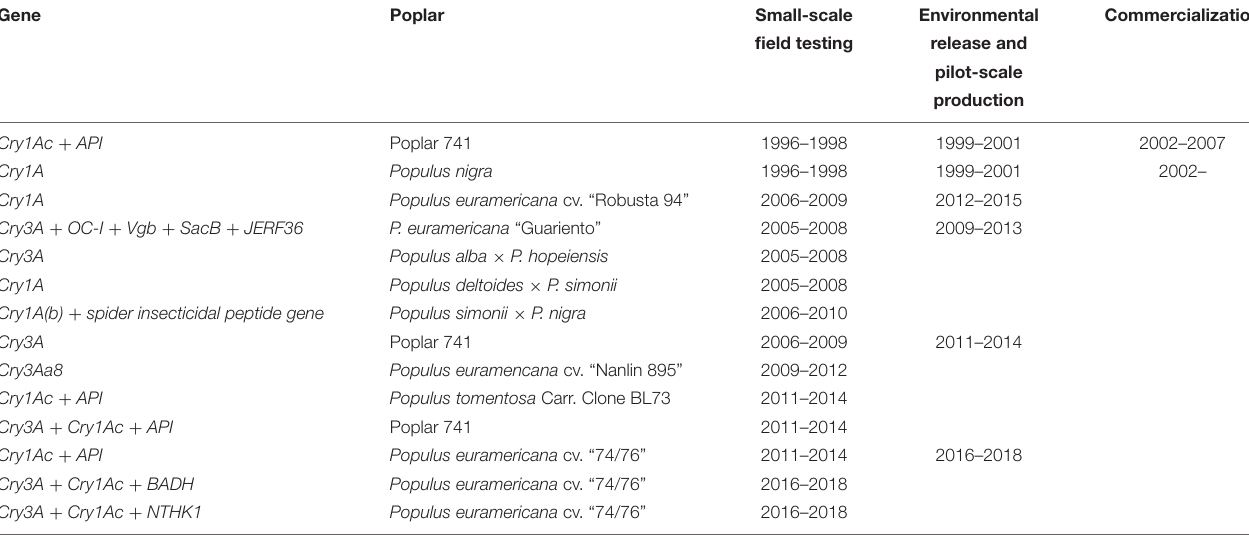
TABLE 1 | The administrative approval process of insect-resistant poplars in China. Gene